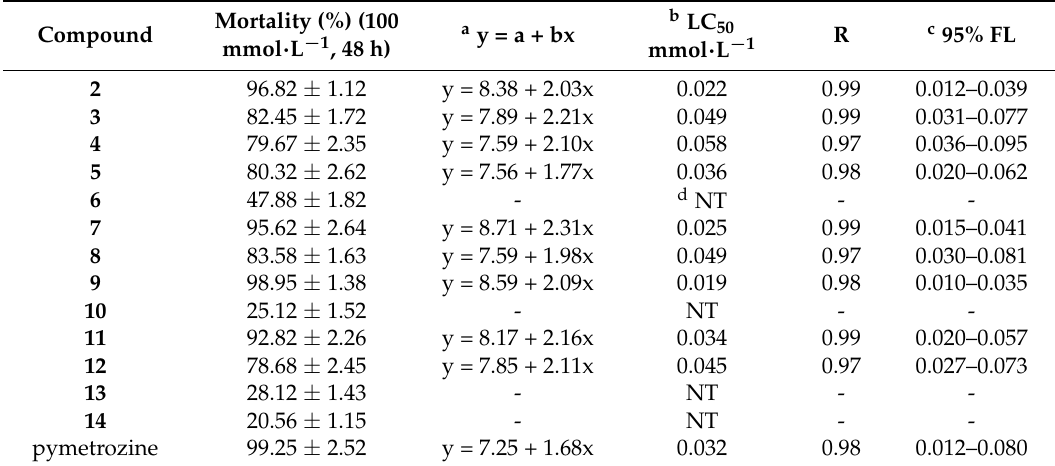
Table 1. Aphicidal activity against Aphis glycines of target compounds 2 –